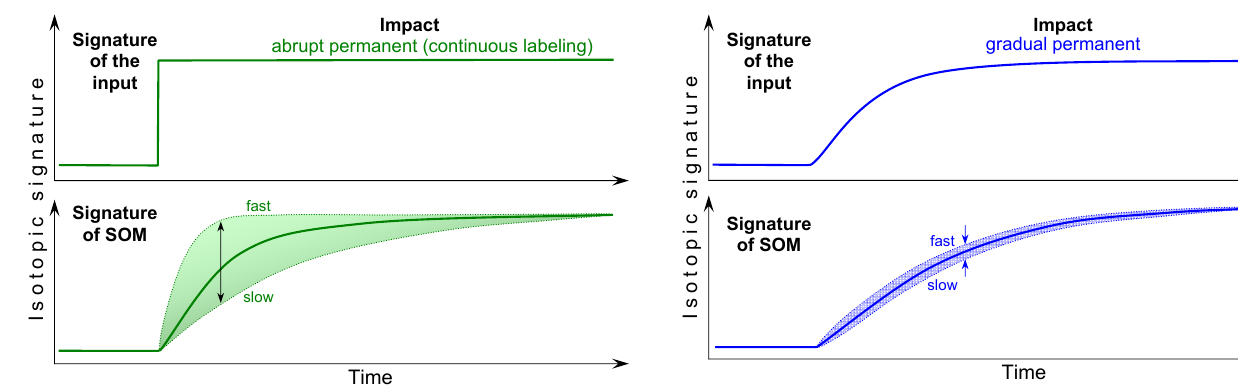
Fig. 2. Abrupt permanent impact of isotopic signature of C input (above) and its effect on changes of isotopic signature of soil organic matter (below). The changes of isotopic signature are presented for bulk SOM (fat curve), as well as for pools with slow and fast turnover (dotted lines). The hight of arrows and the shaded area showing the differences in isotopic signature between the slow and fast pools is proportional to the sensetivity of the approach for each period. Explanations in text. Isotopic fractionations are not considered here, and theredore the SOM pools have identical isotopic compositions before the impact and at new steady state.